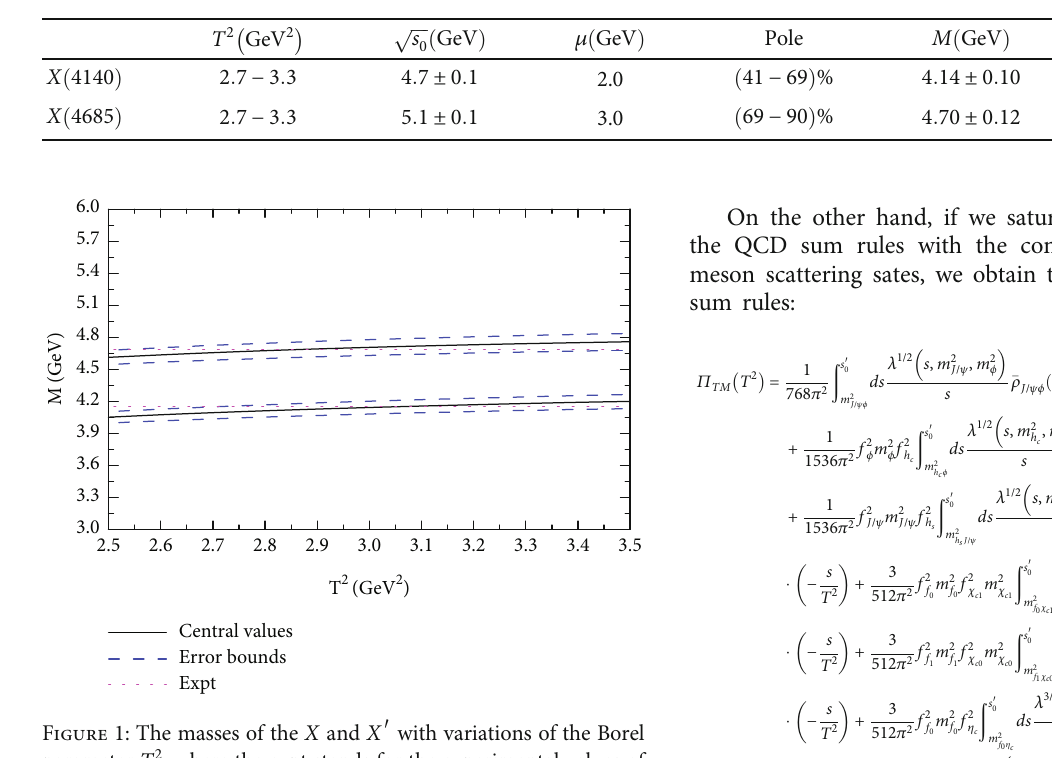
Table 2: The Borel windows, continuum threshold parameters, and ideal energy scales of the spectral densities, pole contributions, masses and pole residues for the axialvector tetraquark states.